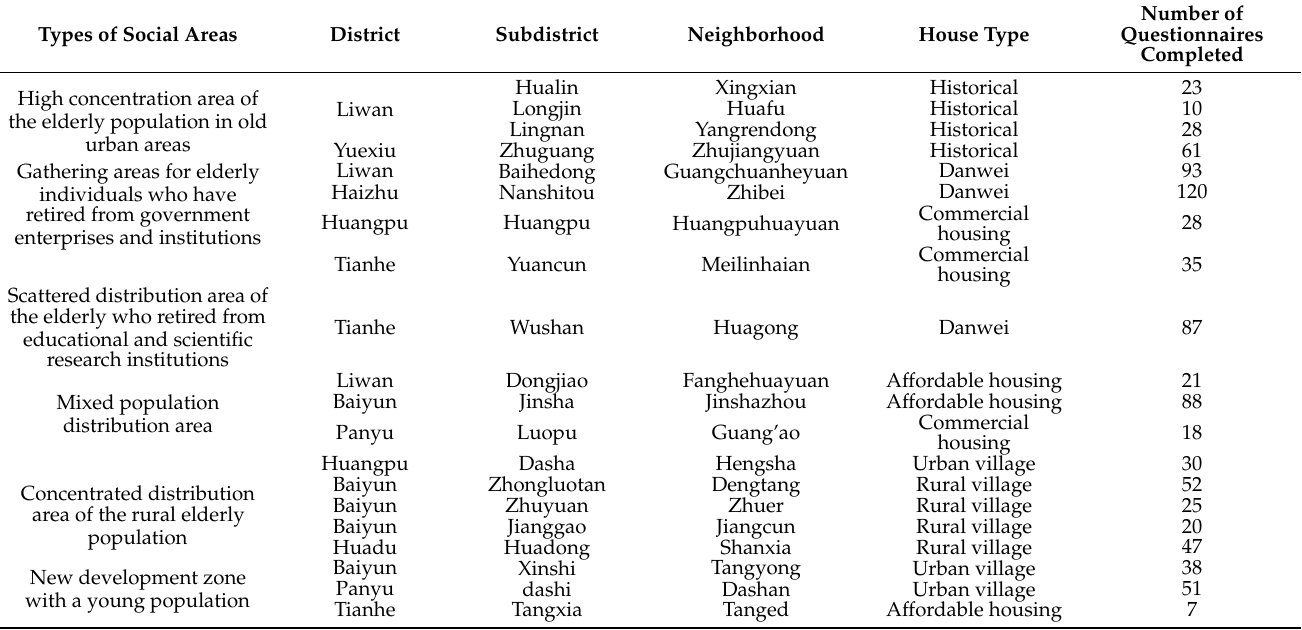
Table 1. Summary statistics for the sampled neighborhoods.